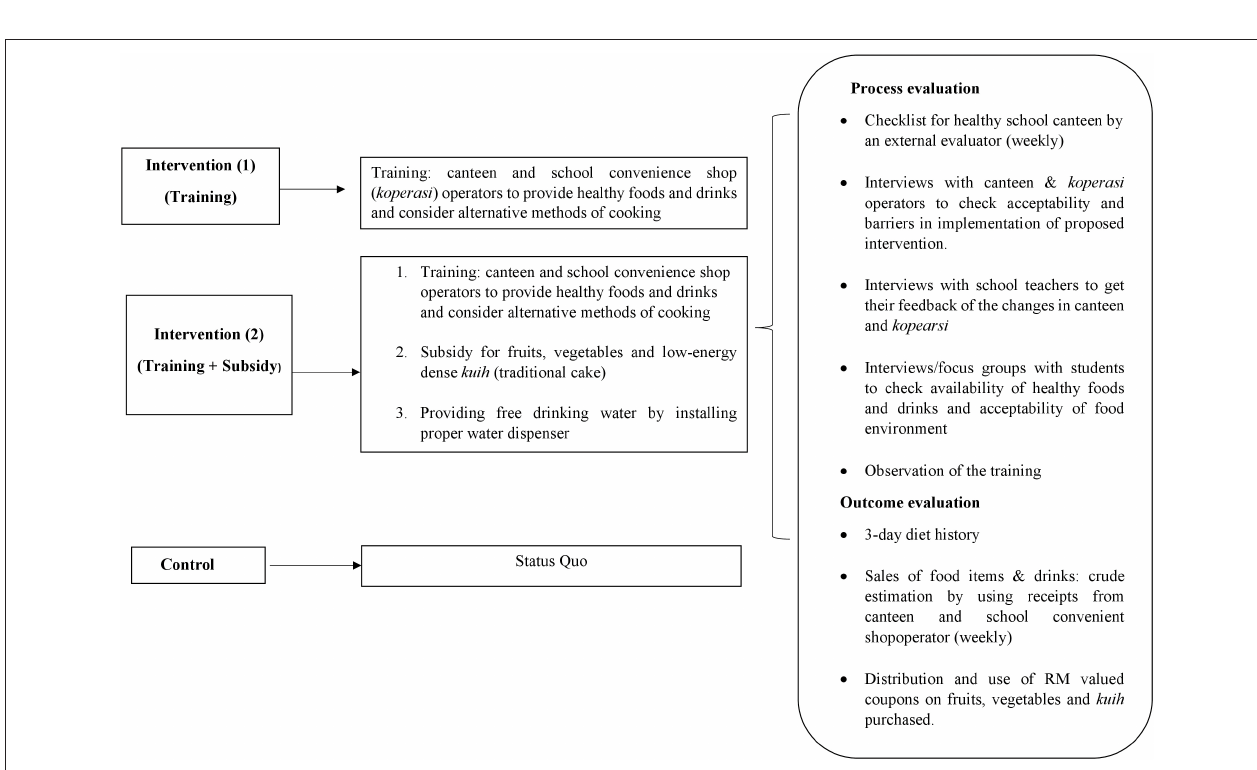
FIGURE 1 | Summary of enrolment, intervention and assessment procedures based on the SPIRIT figure.